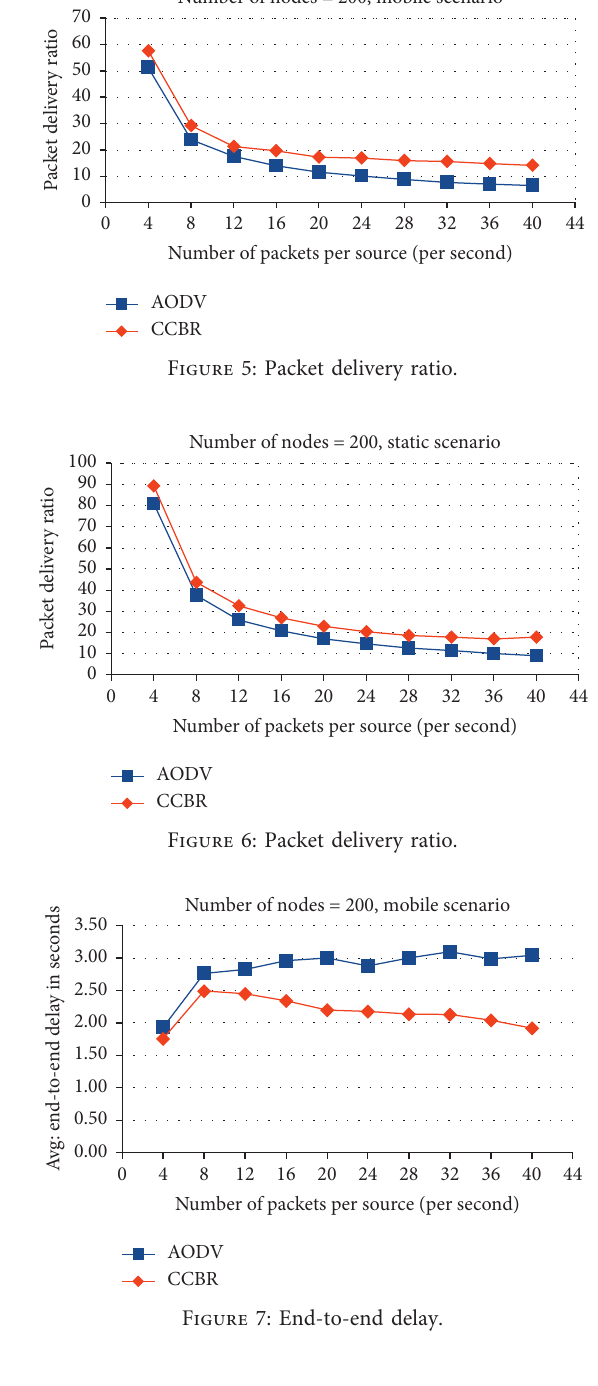
Table 1: Simulation parameters for 100 nodes’ scenario.